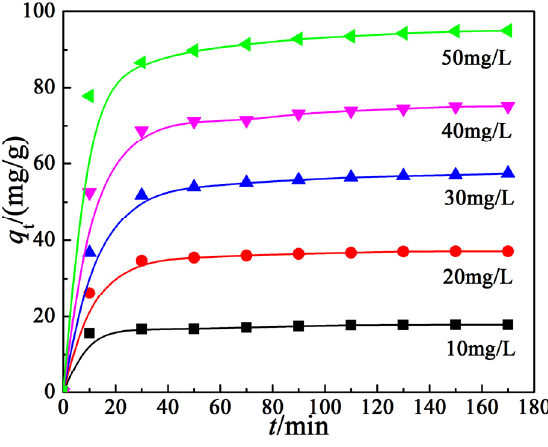
Figure 4. Effect of initial dye concentration and contact time on the adsorption.